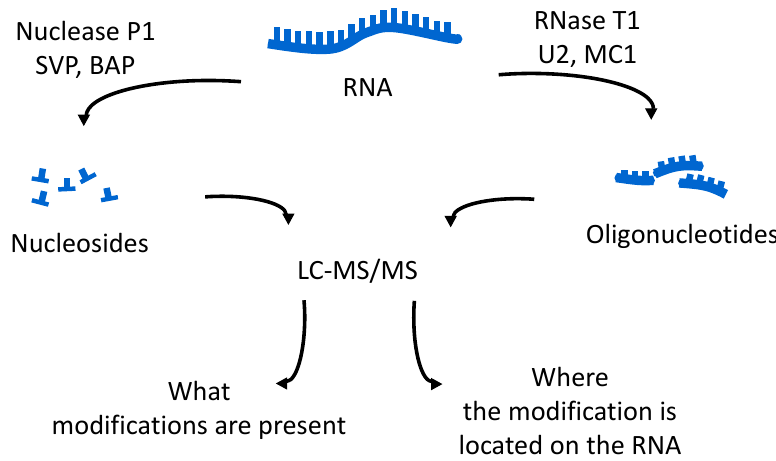
Figure 4. Flowchart of RNA modification mapping experiment using enzymatic digestion for generation of both nucleoside and oligonucleotide samples to be analyzed by liquid chromatography tandem mass spectrometry (LC-MS/MS). SVP: snake venom phosphodiesterase; BAP: bacterial alkaline phosphatase; RNase: ribonuclease.